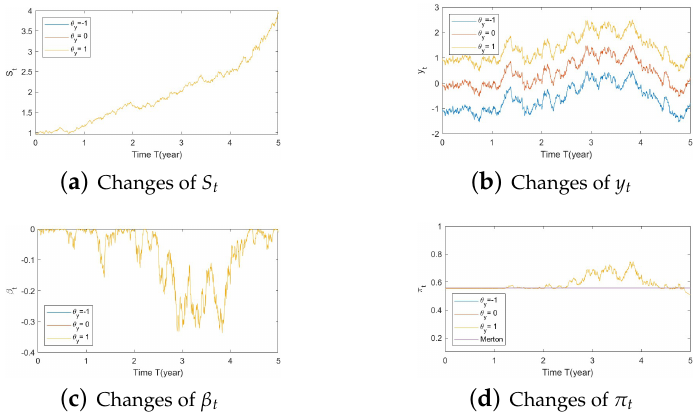
Figure A2. Illustrate the impact on ( a ) stock prices, ( b ) driver of elasticity, ( c ) elasticity of volatility, and ( d ) optimal stock allocations when varying θ y ( e . g ., θ y = − 1,0,1 )